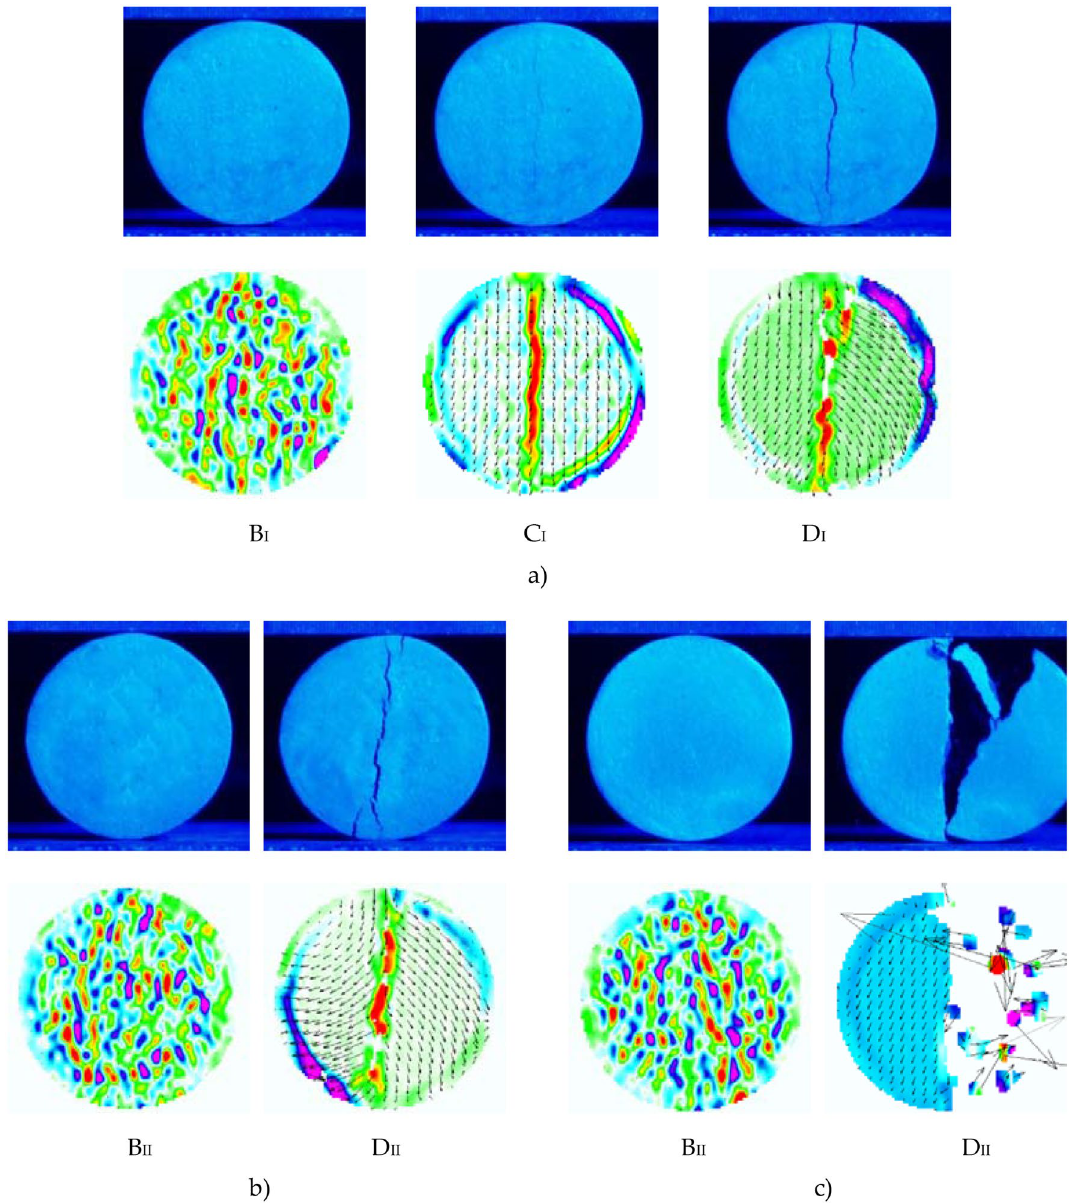
Figure 8. Fracture propagation and displacement vector fields of specimens at selected points ( B – D ) on the load–displacement curve: ( a ) Type I; ( b ) Type II for 1.63 g/cm 3 initial dry density; ( c ) Type II for 1.70 g/cm 3 initial dry